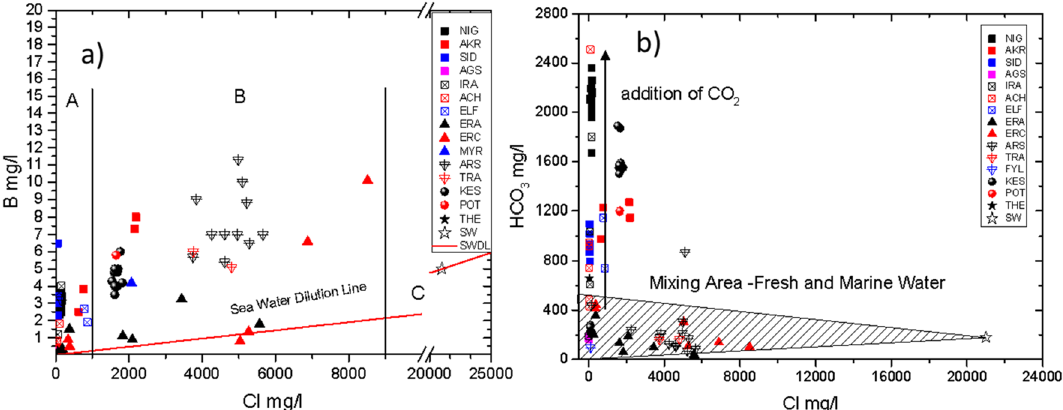
Figure 3. ( a ) Cl − versus B for the studied areas. Area A (mixing between cold water and deep thermal water of SR), area B (mixing between cold water and deep thermal water of XK, LFS,) and line C (seawater dilution line- SWDL). ( b ) HCO the mixing between fresh water of the area and marine